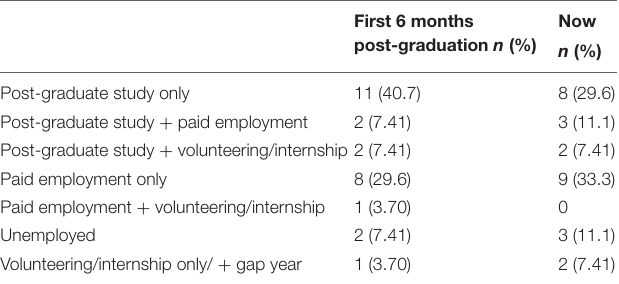
TABLE 4 | Pursuits of participants who graduated 1–5 years